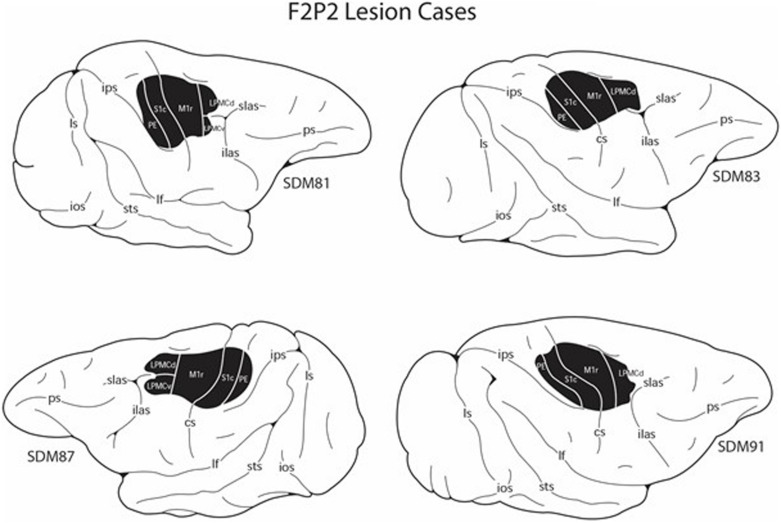
Line drawings of the lateral surface of the cerebral cortex showing the M1 + LPMC + anterior parietal cortex lesion site locations (blackened area) in the four F2P2 lesion cases. Detailed descriptions of the histological and cytoarchitectonic characteristics of each lesion are provided in previous reports along with microstimulation maps of the cortical surface that were used to guide the placement of each lesion (Morecraft et al., 2015; Darling et al., 2016). cs, central sulcus; ecs, ectocalcarine sulcus; ilas, inferior limb of the arcuate sulcus; ios, inferior occipital sulcus; ips, intraparietal sulcus; lf, lateral fissure; ls, lunate sulcus; ots, occipito-temporal sulcus; ps, principal sulcus; slas, superior limb of the arcuate sulcus; sts, superior temporal sulcus.